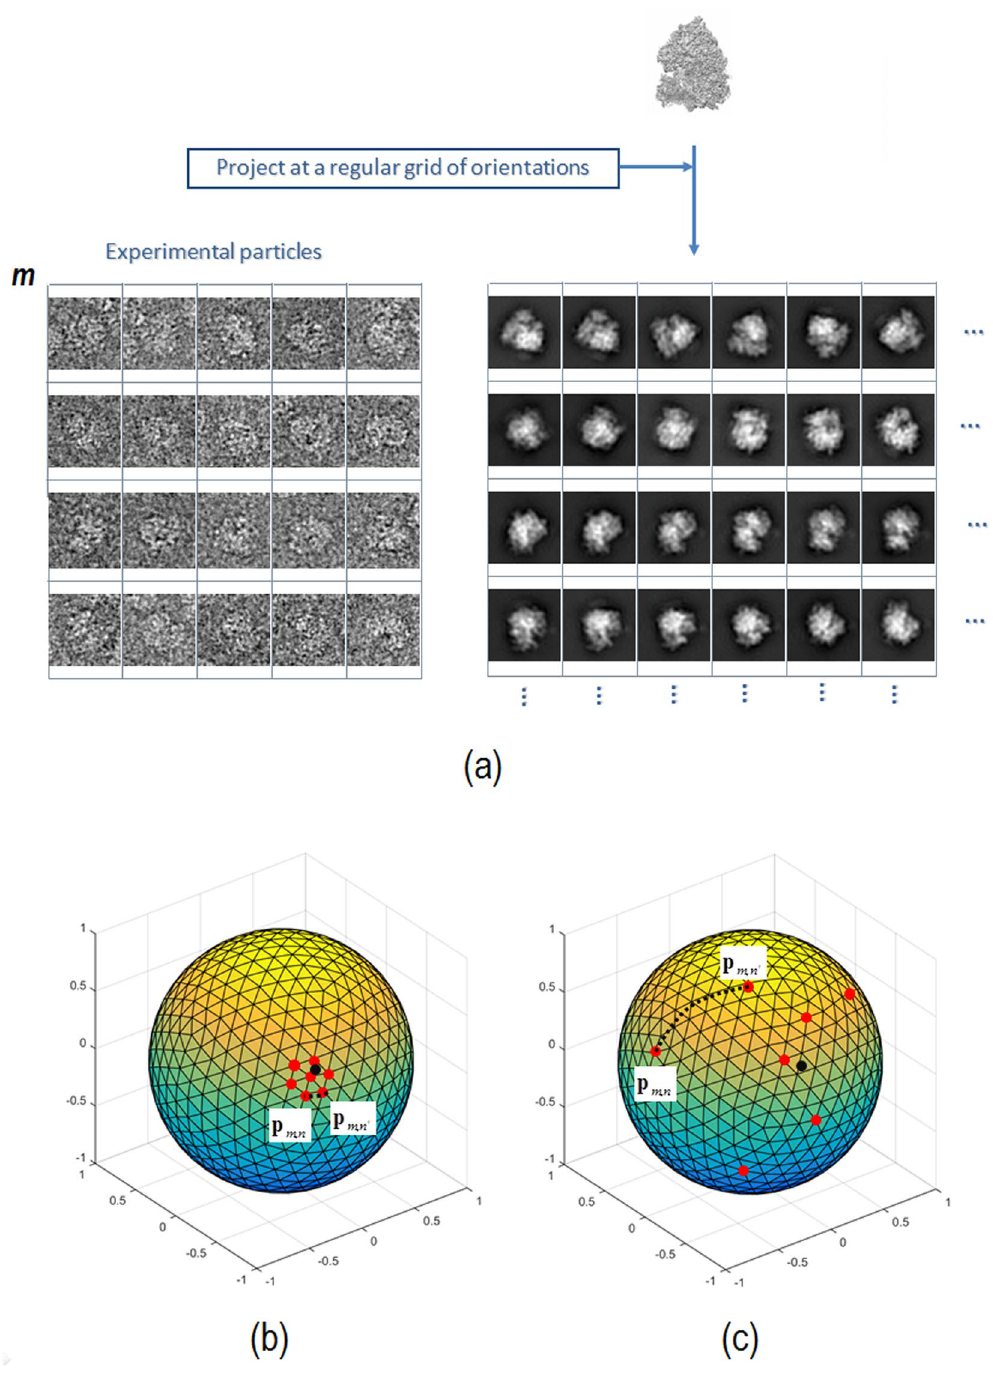
Figure 1. ( a ) Selected experimental particle labeled as m marked in the figure at the left part with a red square. Al the right it is shown the map projection set with the seven most similar map projections, selected according to their normalized cross correlation score, marked with red squares. In ( b ) and ( c ) are shown plots of the orientations (red points) of the most similar map projections. The plots ( b ) and ( c ) represent examples of tight and spread orientation clusters